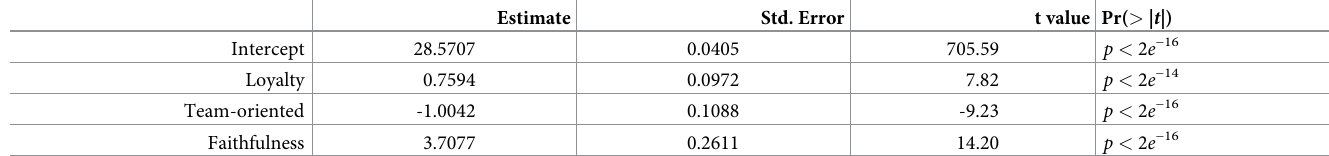
Table 1. Influence over skill acquisition of loyalty, TOB and faithfulness (linear model). We report the estimated slope value, their standard deviation and their signifi- cance difference with respect to a zero slope. All players have 100 games of experience.